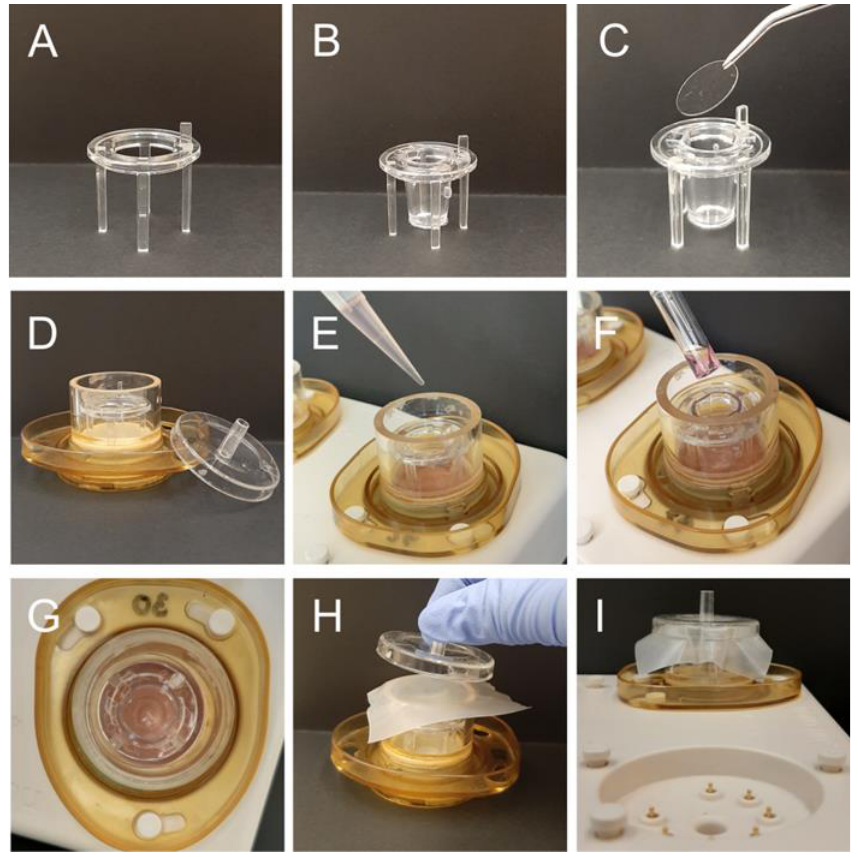
Figure 3. Sample preparation for TTFields treatment. ( A ) Holder for the inserts with semi-permeable membranes (0.4 µm pore size). ( B ) The insert was placed into the holder. ( C ) Glass coverslip (12 mm diameter) to protect the slices from condensation water. ( D ) The holder with the insert was placed into a ceramic dish with high walls. ( E ) The ceramic dish, but not the insert, was filled with 2.5 mL of brain slice medium. ( F ) An OHSC or tumor slice was transferred using a wide glass pipette and the excess medium was aspirated. ( G ) The slice should be centrally placed on the membrane of the insert. ( H ) Coverslip, parafilm and lid covered the ceramic dish which was ( I ) connected to the base plate for TTFields application.